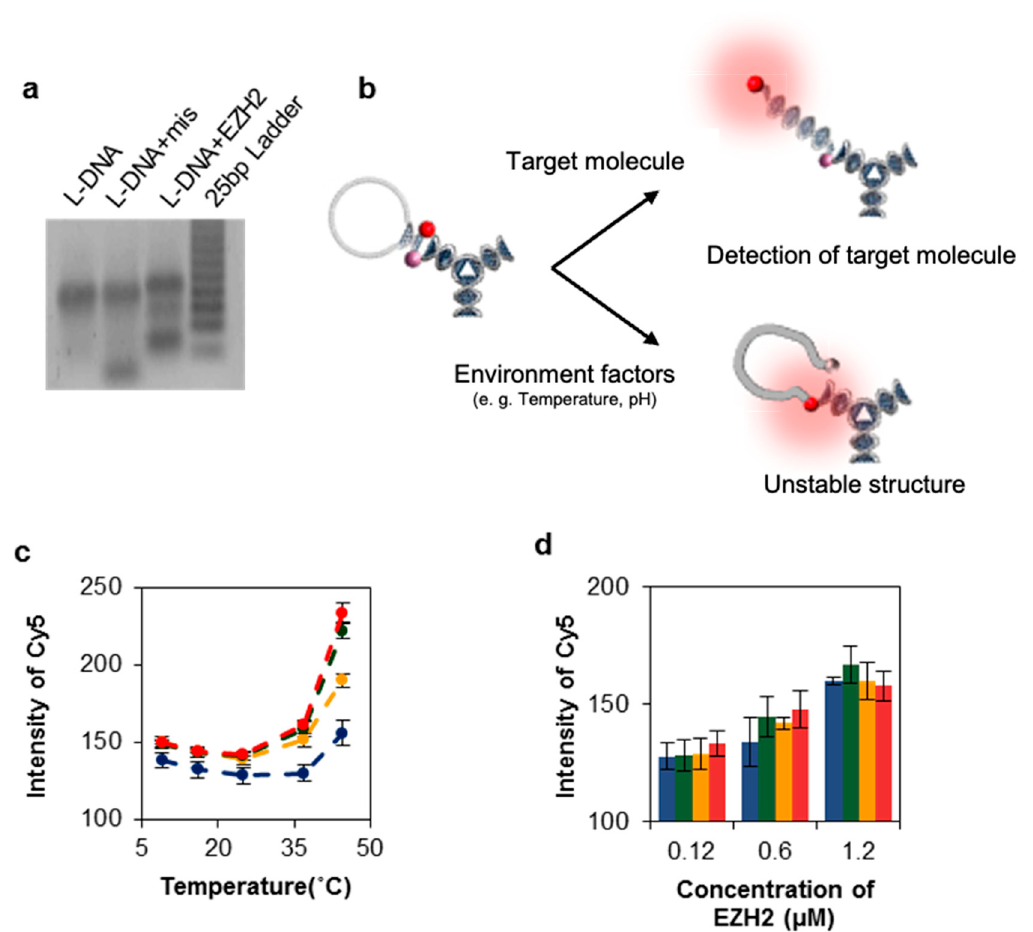
Figure 4. Evaluation of both thermodynamic stability and detection efficiency of L-DNA and its partial constructs. ( a ) Specific interaction between L-DNA and its complementary pair in a 3% agarose gel. The same amounts (6 µ M) of mismatched oligonucleotide (mis, 5 ′ - CAT ATG GGC TCC ATC GGC GCA-3 ′ ) and fully matched oligonucleotide (5 ′ -CAG ATT TCT TCC CAG TCT GGC-3 ′ ) were used for comparison. ( b ) Schematic of the detection mechanism of L-DNA in solution. L-DNAs formed a looped structure in molecular beacon target capture. After target binding, the beacon adopted an open state, emitting a strong Cy5 signal. Environmental factors such as temperature and pH can destabilize the loop–stem structure and can affect the fluorescence signal. ( c ) Cy5 signal of L-DNA (red), Y L + Y 1 (orange), Y L + Y 2 (green), and Y L (blue) at different temperatures (9, 16, 25, 37, and 45 °C). ( d ) Cy5 signal variations of L-DNA at different target concentrations at 16 °C. In both (c) and (d), the fluorescent intensities of Cy5 measured by spectrophotometric analysis were obtained from triplicate experiments.